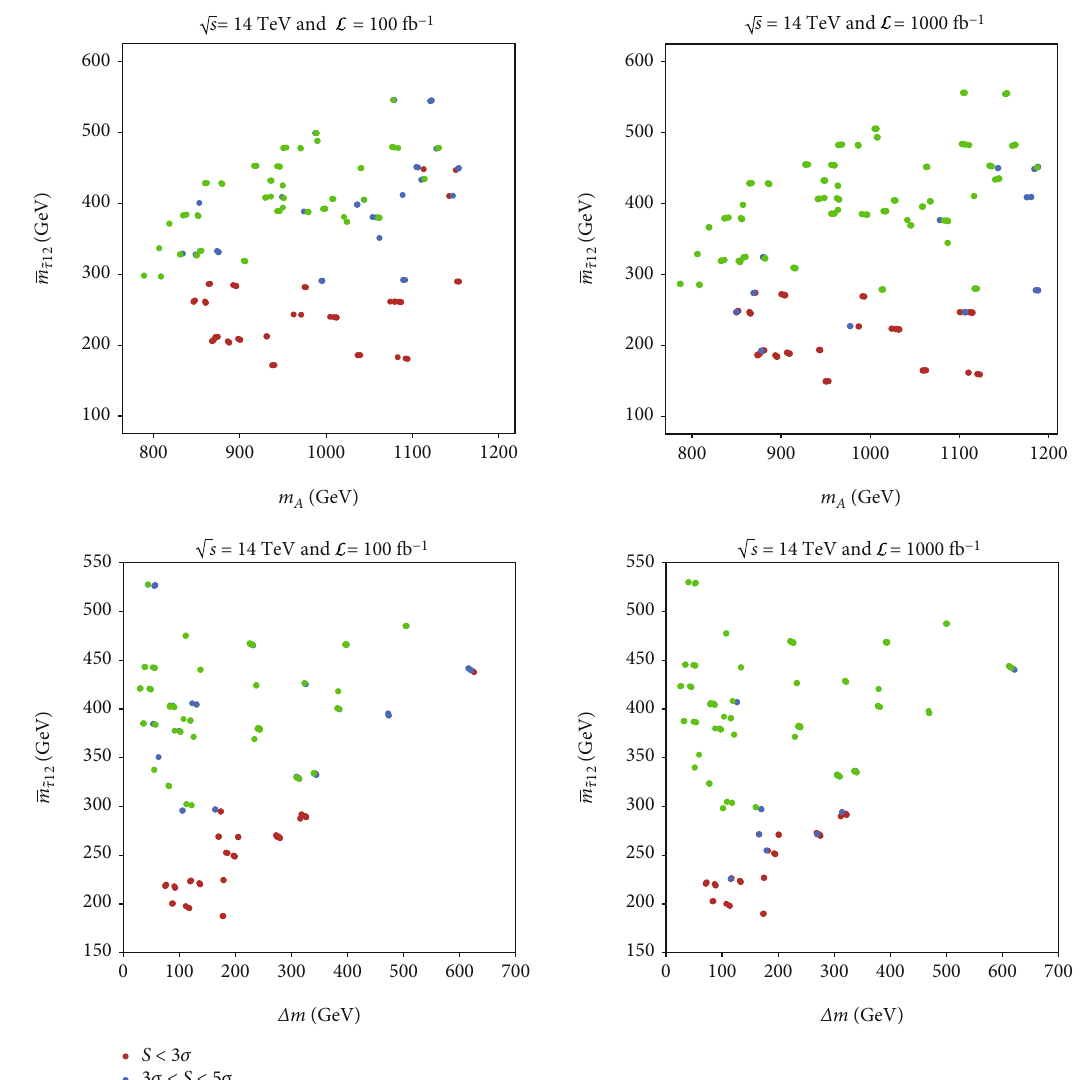
Figure 9: Signal signi fi cance in the ½ m , A τ (cid:2) plane (a, b) and ½ tan β , A τ (cid:2) plane (c, d), within Scenario II for a center-of-mass energy of ffiffi p A = 14 TeV and total integrated luminosities of 100 fb − 1 (a, c) and 1000 fb − 1 (b, d). Benchmarks with signi fi cances below the evidence s level ( S < 3 σ ), between the evidence level and the discovery level ( 3 σ < S < 5 σ ), and above the discovery level ( S > 5 σ ) are shown in red, blue, and green,